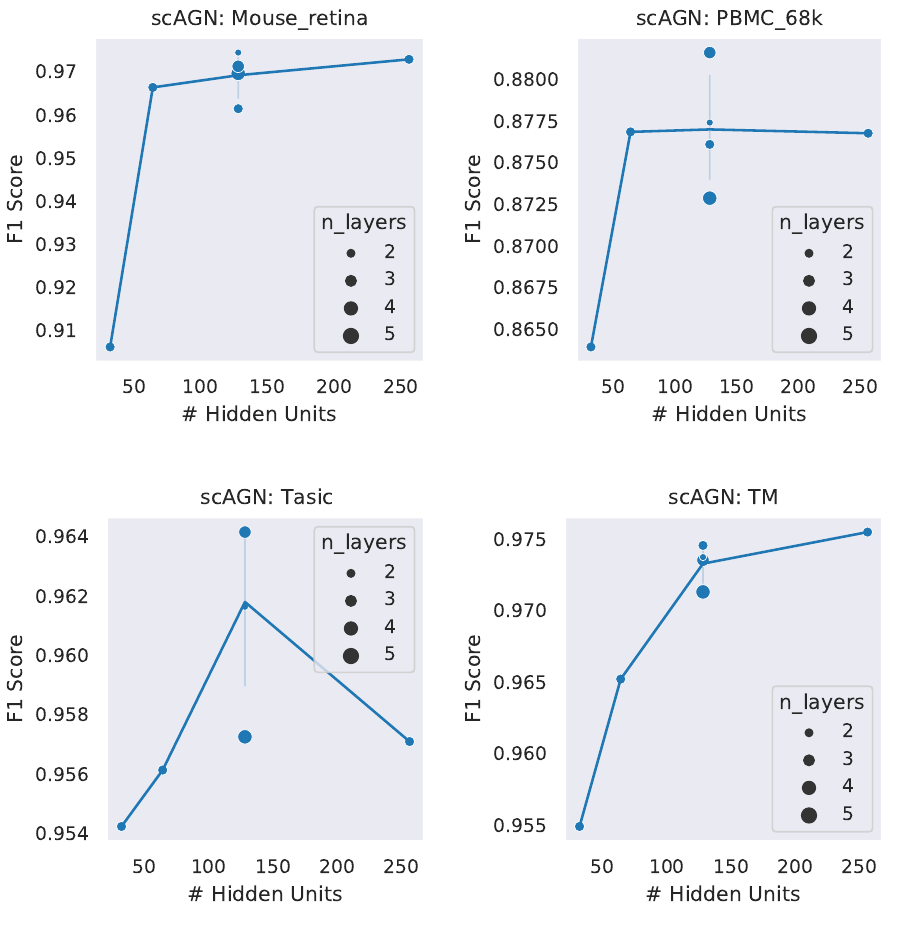
Figure 9. F1 score with the number of hidden units and the number of layers. The number of hidden units used were 32, 64, 128, and 256. The number of layers were varied from 2 to 5. The size of the bubble represents the number of layers used in the graph neural network. For fixed hidden units, varying the number of layers does not provide a definite conclusion on a trend of the F1 score with the number of layers. Lines were drawn passing through the average of the number of layers where the number of hidden units is fixed. With the Tasic dataset, we see an exception where the trend of the F1 score with the number of hidden units is